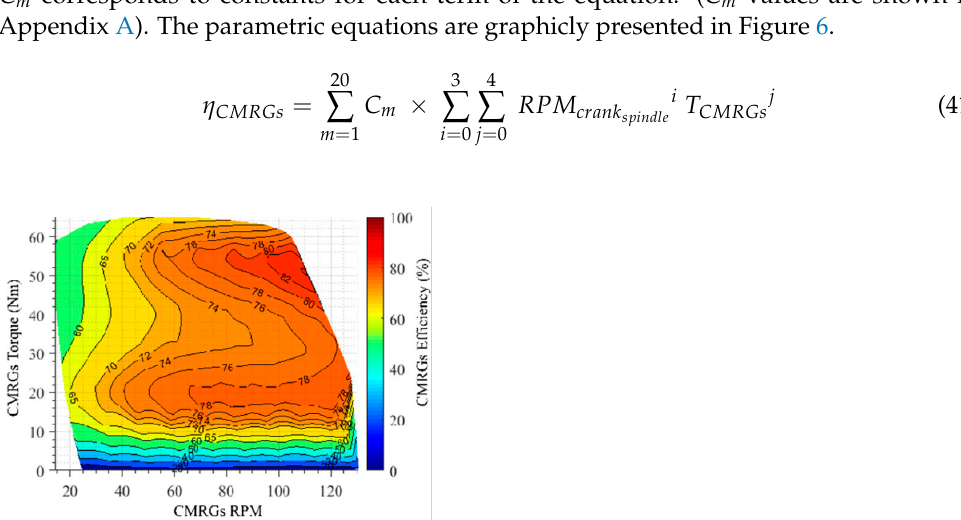
Figure 6. Efficiency map of the CMRGs represented by parametric